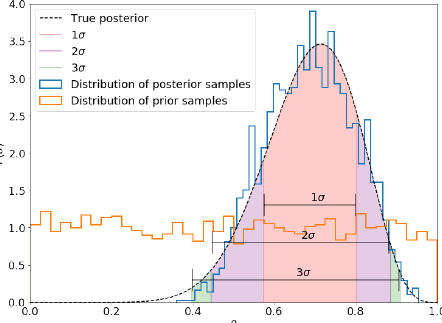
Figure 4. One-dimensional posterior distribution for our example. We plot the prior distribution (red), true posterior (dashed-black), and the posterior calculated by the MHA (blue). We plot 1, 2 and 3 σ confidence regions for the estimation of p